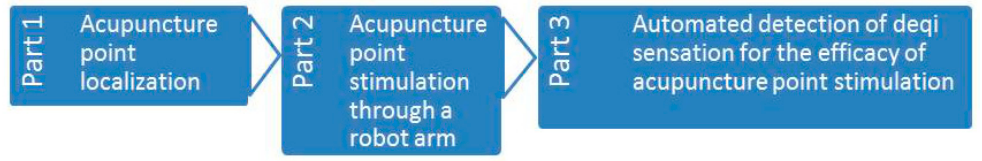
Figure 1. Schematic presentation of the robot-controlled acupuncture system. Note: Part 3 is still under development.